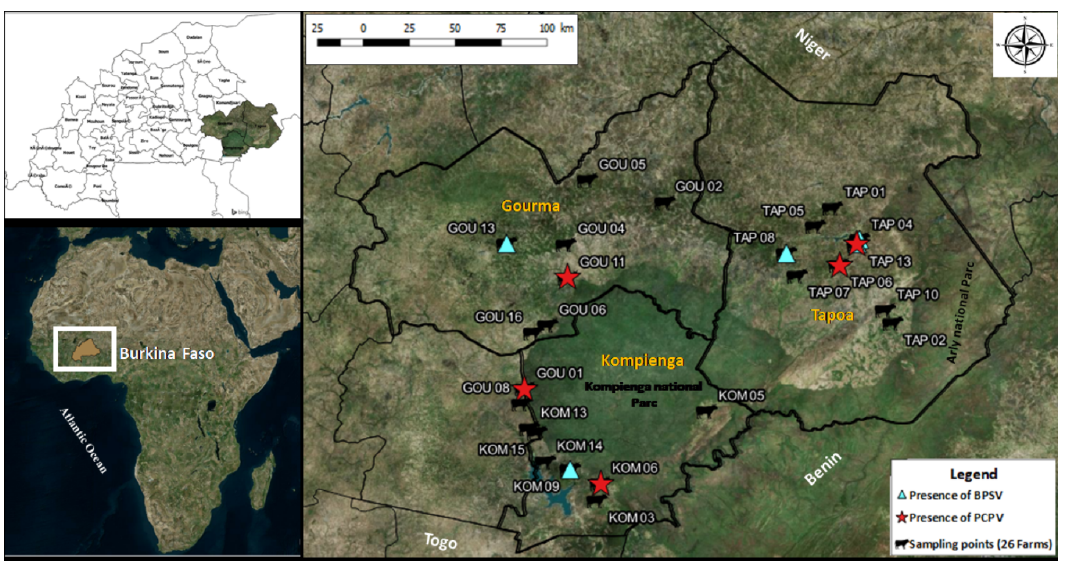
Figure 2. Neighbor-joining phylogenetic tree based on the partial sequences of the major envelope protein (B2L) gene of Bovine Papular Stomatitis and Pseudocowpox virus. Origins and accession numbers of reference sequences of BPSV (Bovine Papular Stomatitis Virus), PCPV (Pseudocowpox virus) as well as that of RVFV (Rift Valley Fever Virus) are indicated. Blue circles refer to samples from elsewhere in Africa, while red squares correspond to our samples from Burkina Faso.